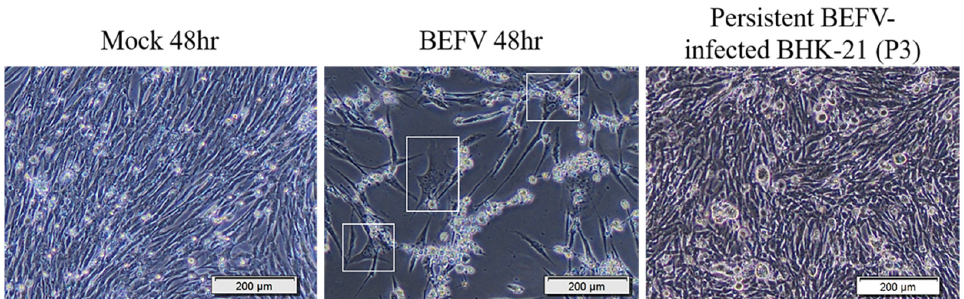
Figure 1. The BHK-21 Cell morphology changes in BEFV infection. Mock 48 hr: The BHK-21 cells were mock infected for 48 hr. BEFV 48 hr: The BHK-21 cells were infected with BEFV for 48 hr. Persistent BEFV infected BHK-21 cells (p3): The BEFV-infected BHK-21 cells survived and maintained their culture (passaged 3 times). The cells were imaged with 400× microscope, and the scale bar showed 200 µm. Table 1. Virus titer of the persistent BEFV-infected BHK-21 cells.